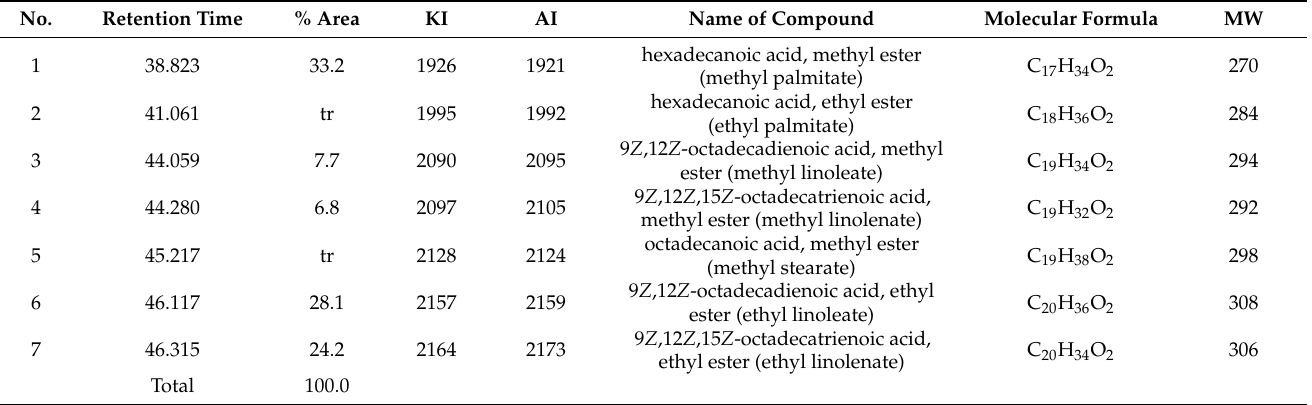
Table 4. Chemical composition of dichloromethane extract of Dioscorea communis berry juice after acid hydrolysis